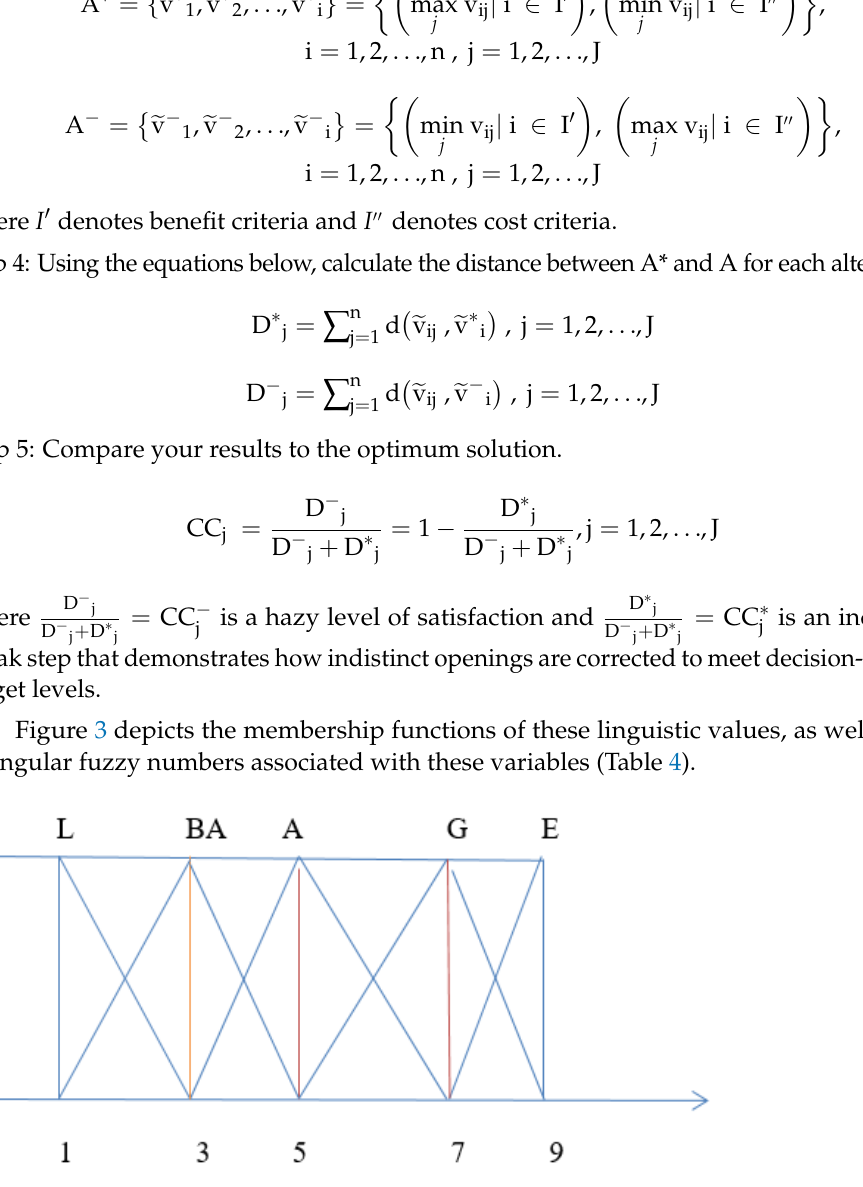
Figure 3. Linguistic values for criteria rating. Table 4. Phonology grade level substitutes.